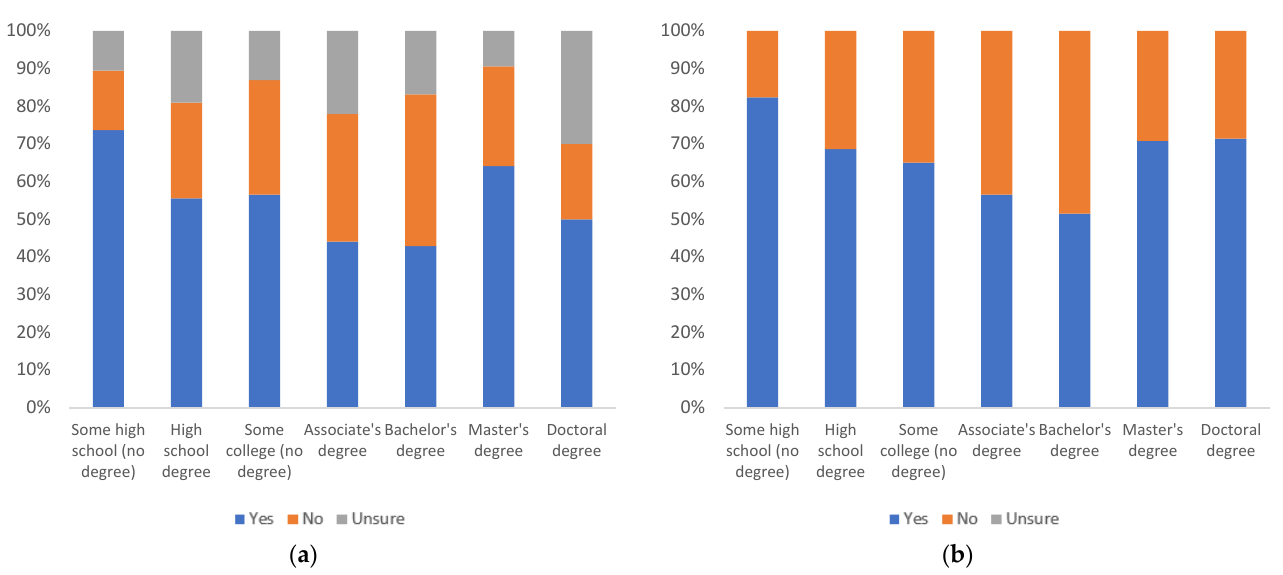
Figure 6. Label helpfulness, by education level: ( a ) with uncertain respondents (left) and ( b ) without uncertain respondents (right).